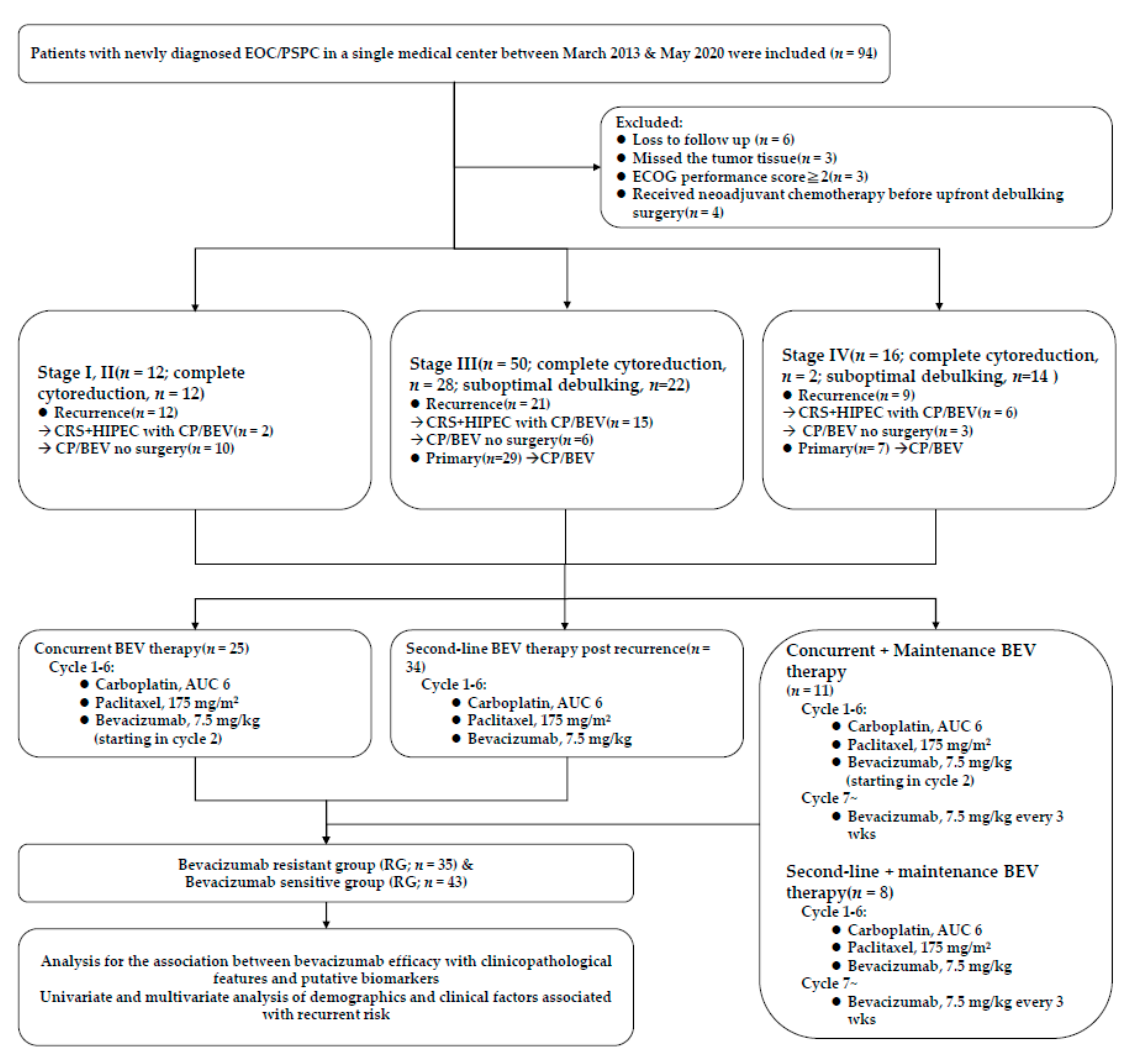
Figure 1. Flow chart of the final patient enrollment. EOC, epithelial ovarian cancer; PSPC, peritoneal serous papillary carcinoma; ECOG, Eastern Cooperative Oncology Group; CRS + HIPEC, cytoreductive surgery and hyperthermic intraperitoneal chemotherapy; CP, carboplatin/paclitaxel; BEV, bevacizumab; AUC, area under curve. Table 1. Association between bevacizumab efficacy and clinicopathological features.